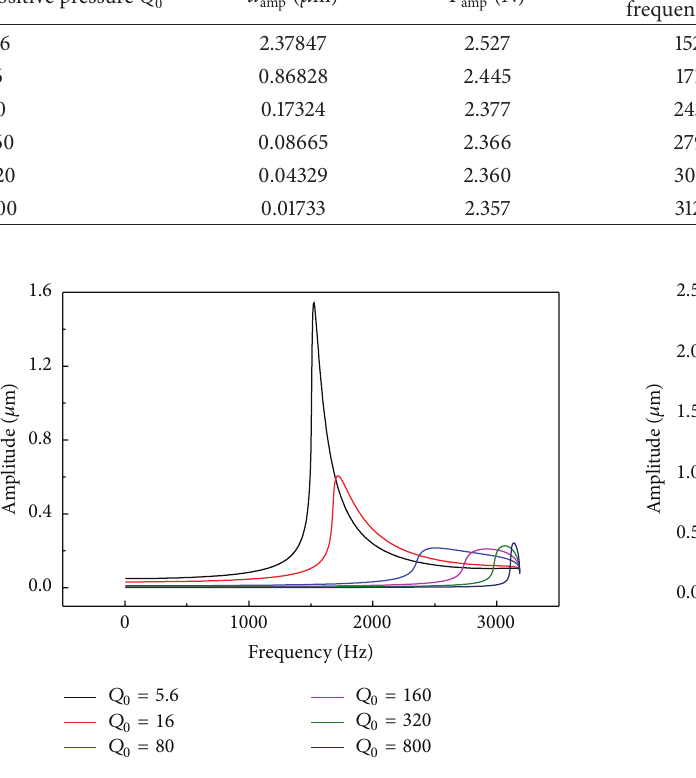
Figure 8: Vibration response of dry friction blade 𝑚 2 with shroud